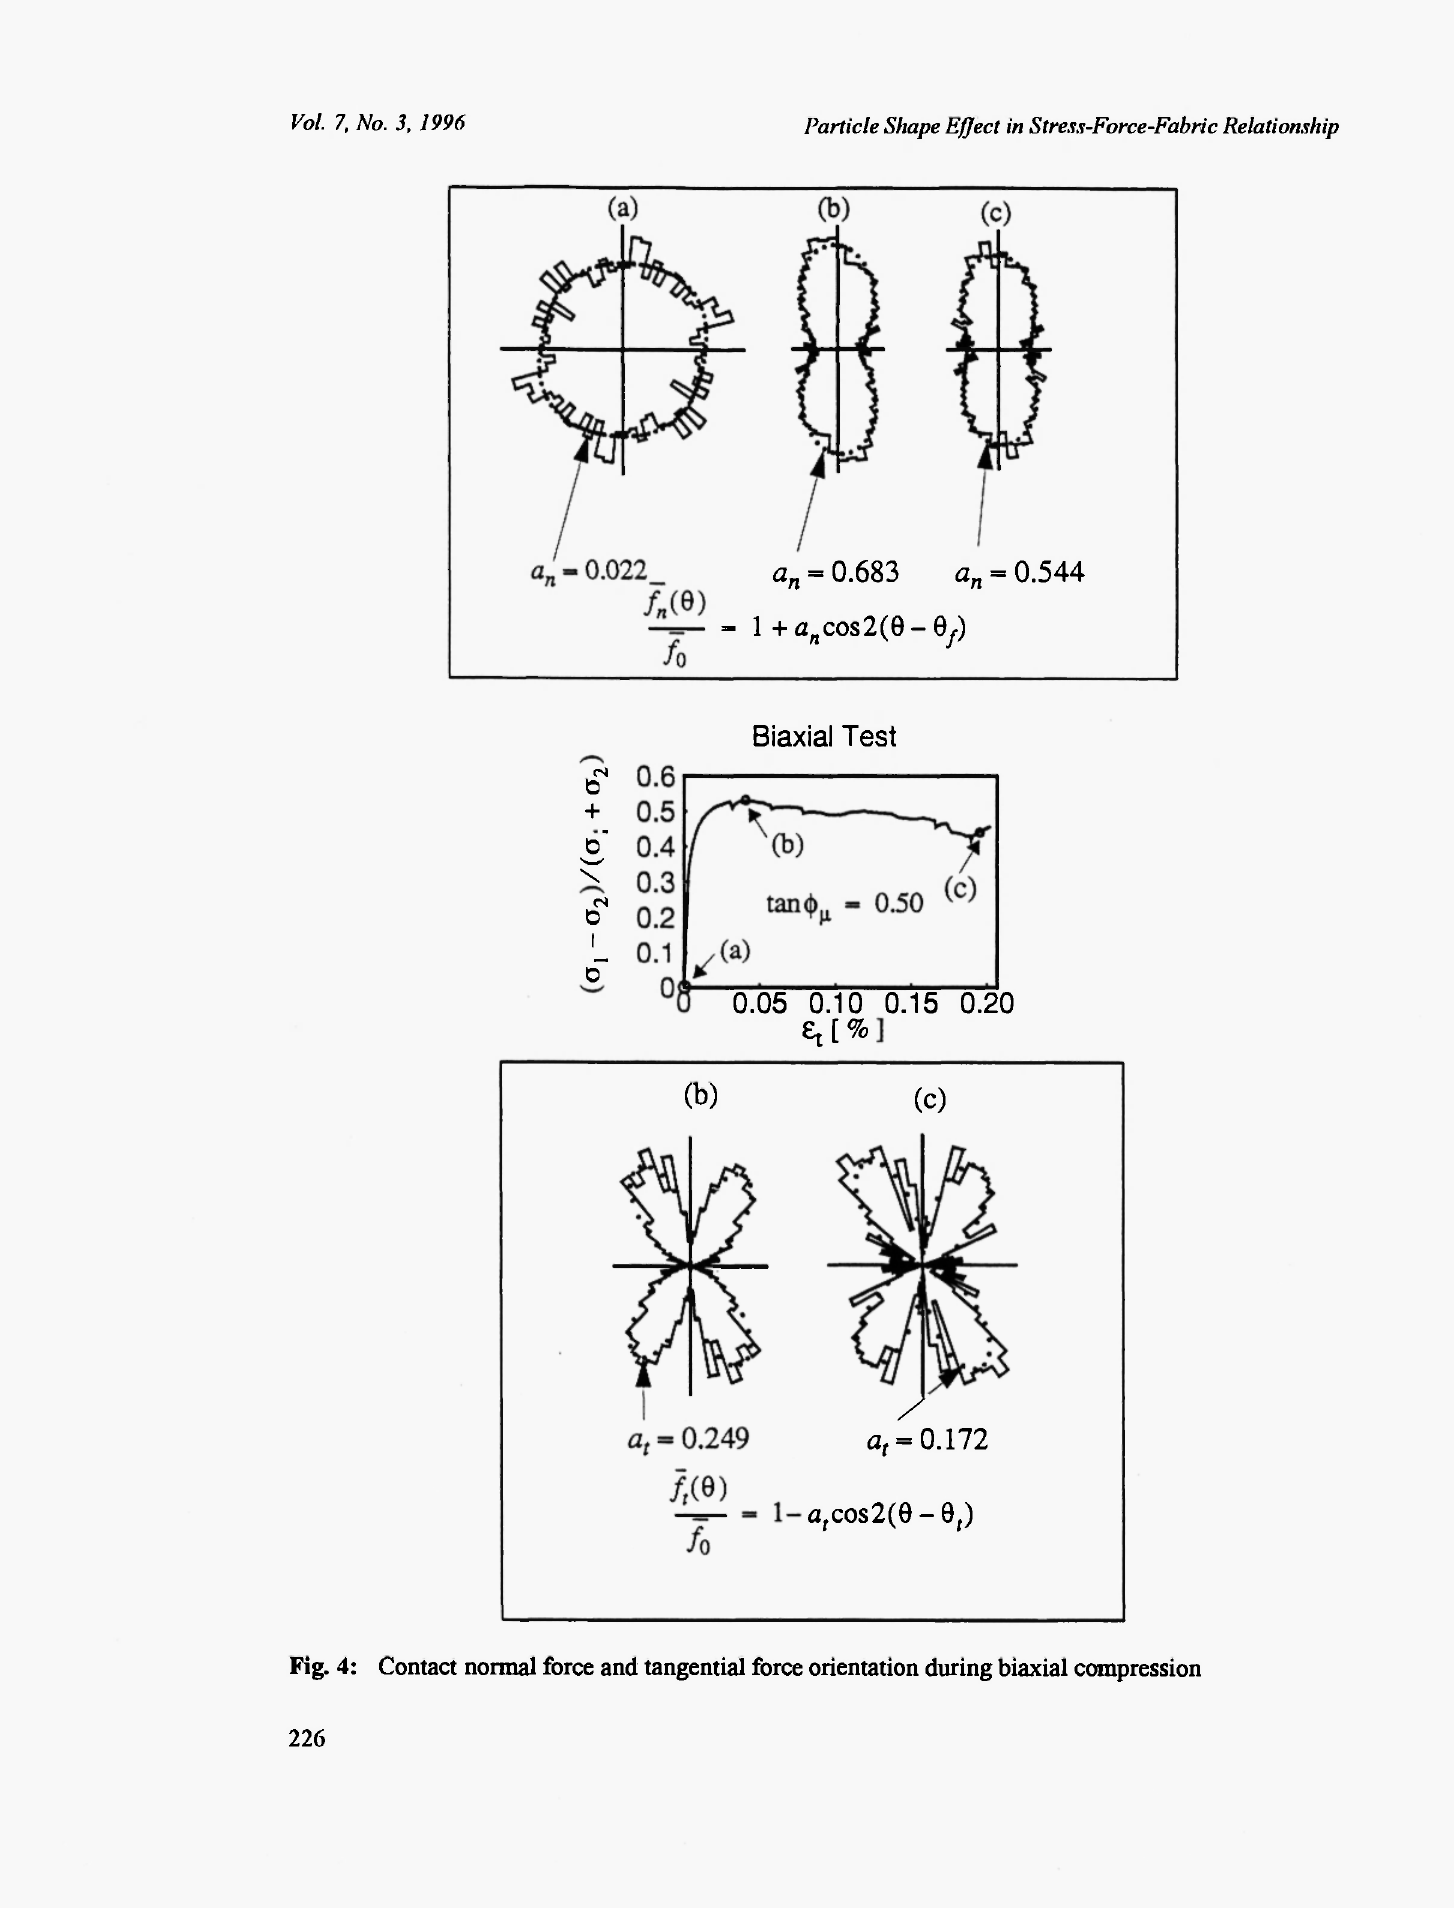
Fig. 4: Contact normal force and tangential force orientation during biaxial